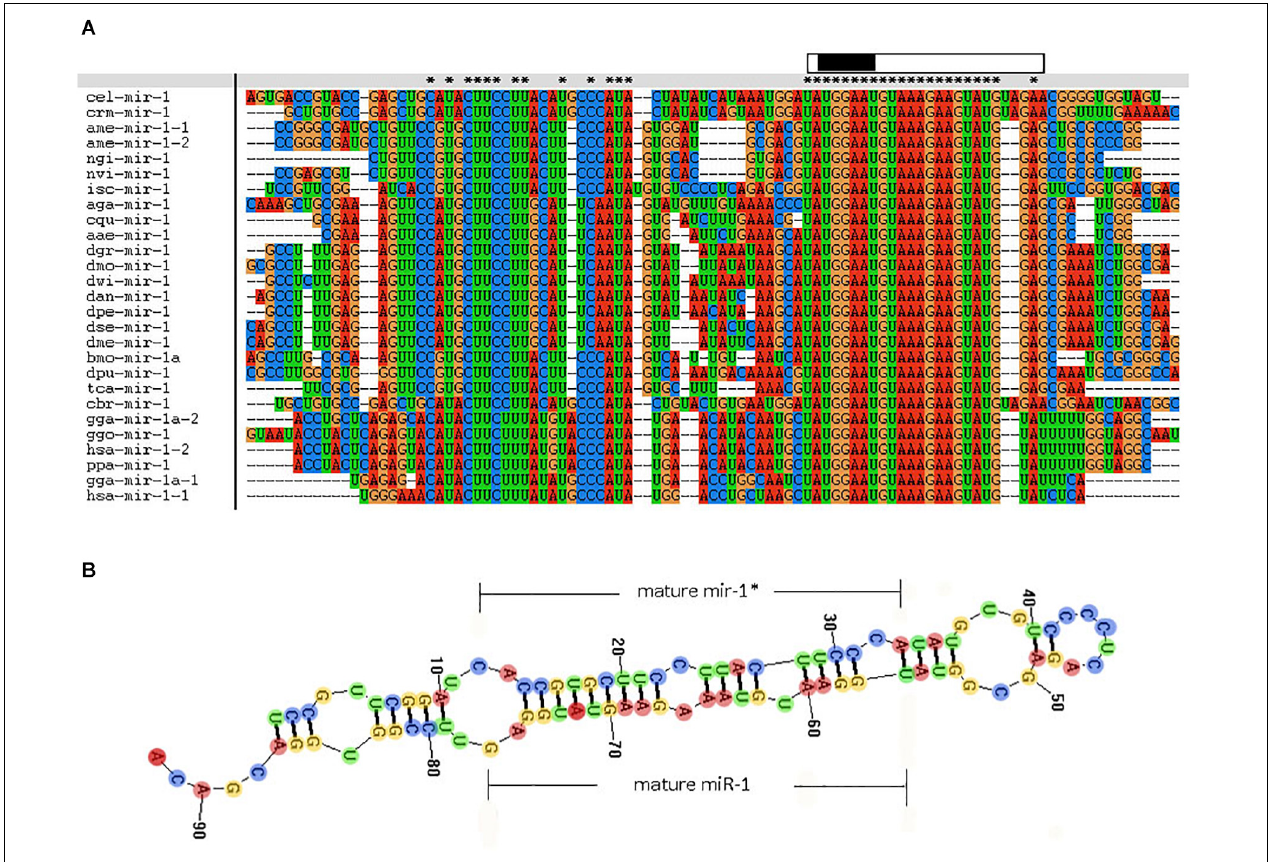
FIGURE 5 | Comparative results of the nucleotide sequence of each species miR-1 (Clustal w software). “ ∗ ” indicates conserved sequences. “partial precursor sequence” is the precursor sequence of miR-1. “Mature” denotes the mature sequence of miR-1. “seed region” is the seed region of